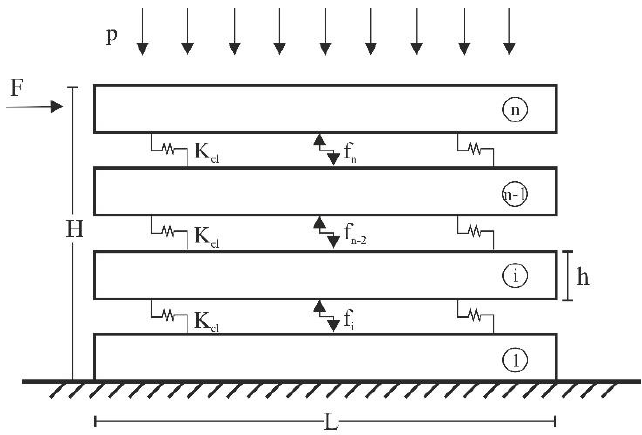
Figure 3. Mechanical model of a typical log-house shear-wall under combined in-plane compression and lateral loads (front view). Reproduced from [25] under the terms and condition of CC BY-NC 4.0 license.